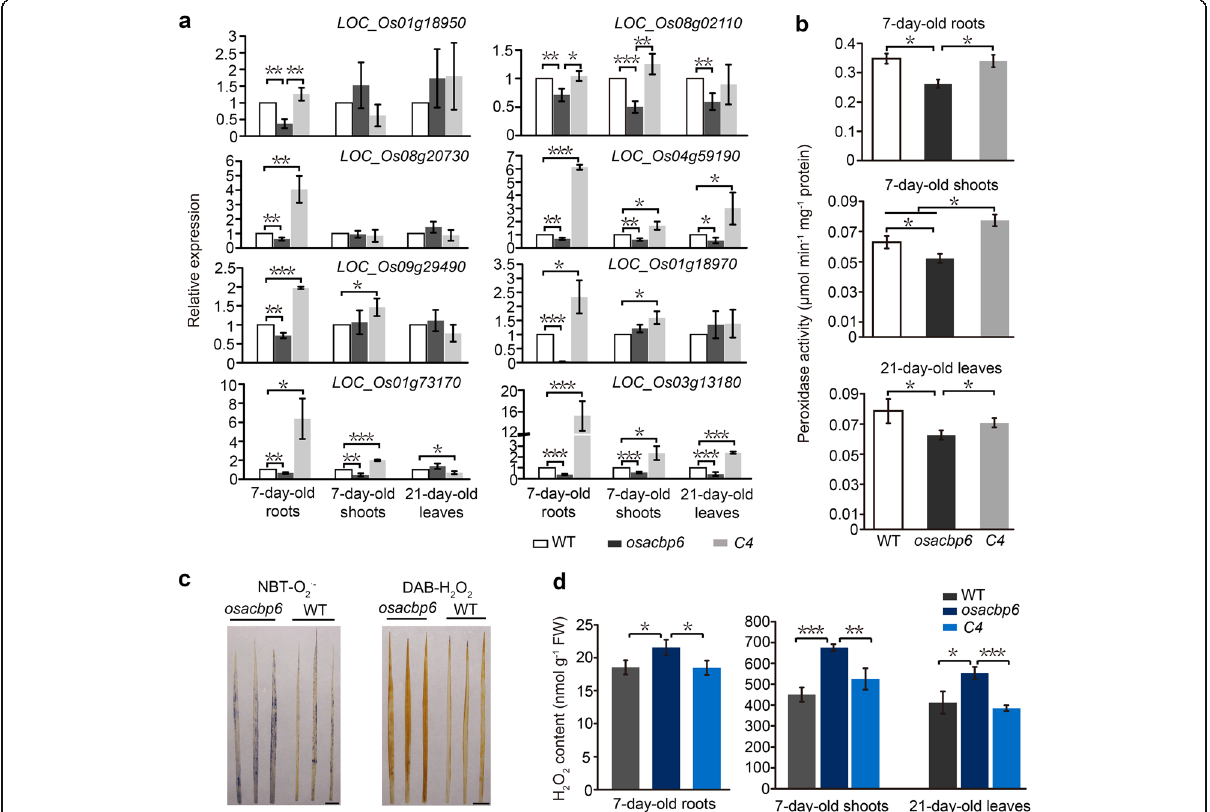
Fig. 5 Disruption of reactive oxygen species homeostasis in the rice osacbp6 mutant. a Relative expression of genes encoding class III peroxidases. Values are mean ± SD ( n = 3). b Comparison of peroxidase activities of the roots and shoots of 7-day-old seedlings and leaves of 21- day-old wild type (WT), osacbp6 and complemented line osacbp6 - C4 ( C4 ). Values are means ± SD ( n = 3). c Accumulation of superoxide anion (O 2 ∙ - ) and hydrogen peroxide (H 2 O 2 ) in the leaf blades of osacbp6 . Leaf blades of 21-day-old WT and osacbp6 were subjected to nitroblue tetrazolium (NBT) staining to detect O 2 ∙ - or 3,3 ′ -diaminobenzidine tetrahydrochloride (DAB) staining to detect H 2 O 2 in the dark for 3 and 24 h, respectively. Bars, 1 cm. d H 2 O 2 content in the roots and shoots of 7-day-old seedlings and leaves of 21-day-old WT, osacbp6 and C4 . Values are means ± SD ( n = 3). Asterisks indicate significant differences as evaluated by Student ’ s t -tests: * P < 0.05, ** P < 0.01, *** P < 0.001. WT, Oryza sativa var. japonica cv.